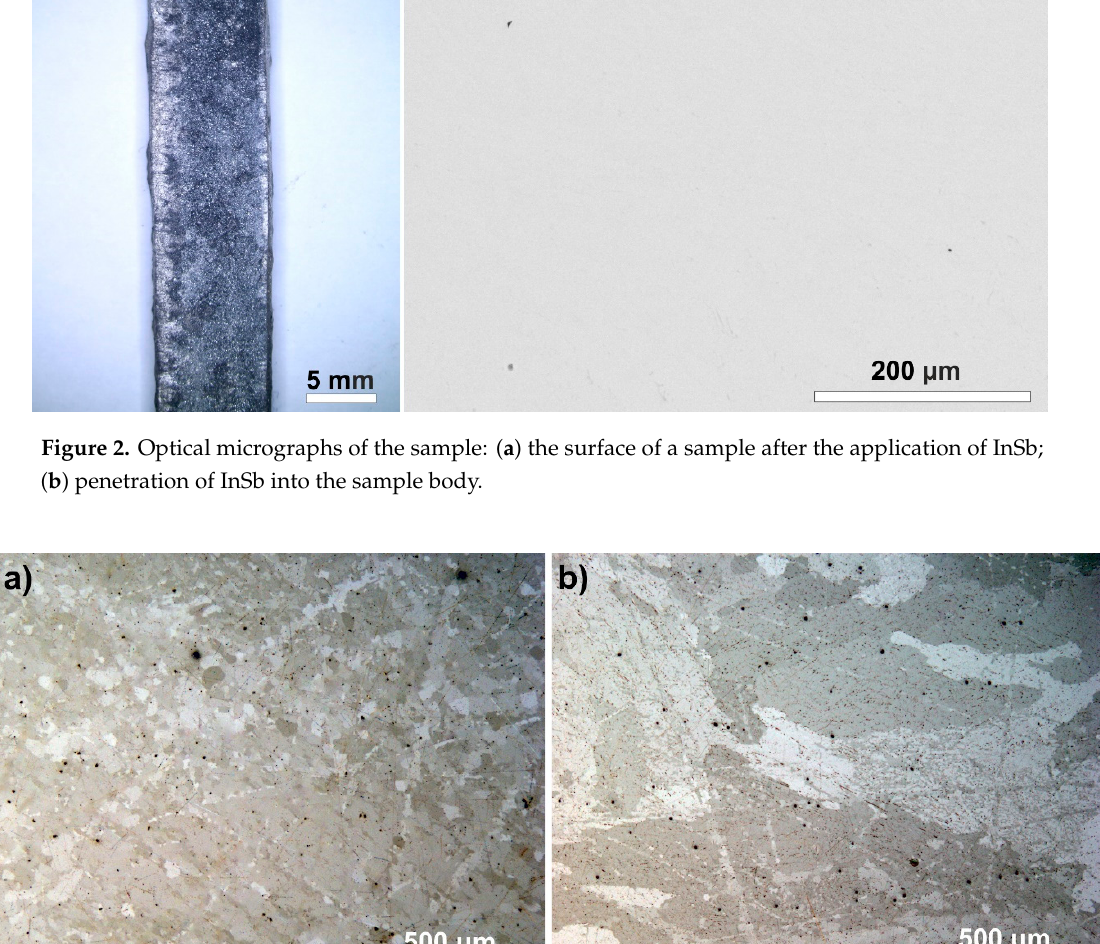
Figure 2. Optical micrographs of the sample: ( a ) the surface of a sample after the application of InSb; ( b ) penetration of InSb into the sample body.